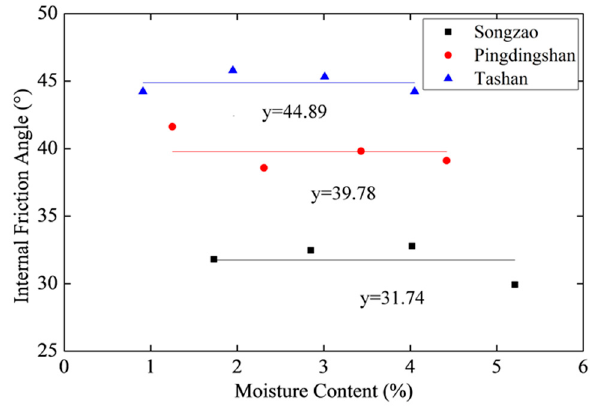
Figure 9. Relationship between internal friction angle and moisture content.